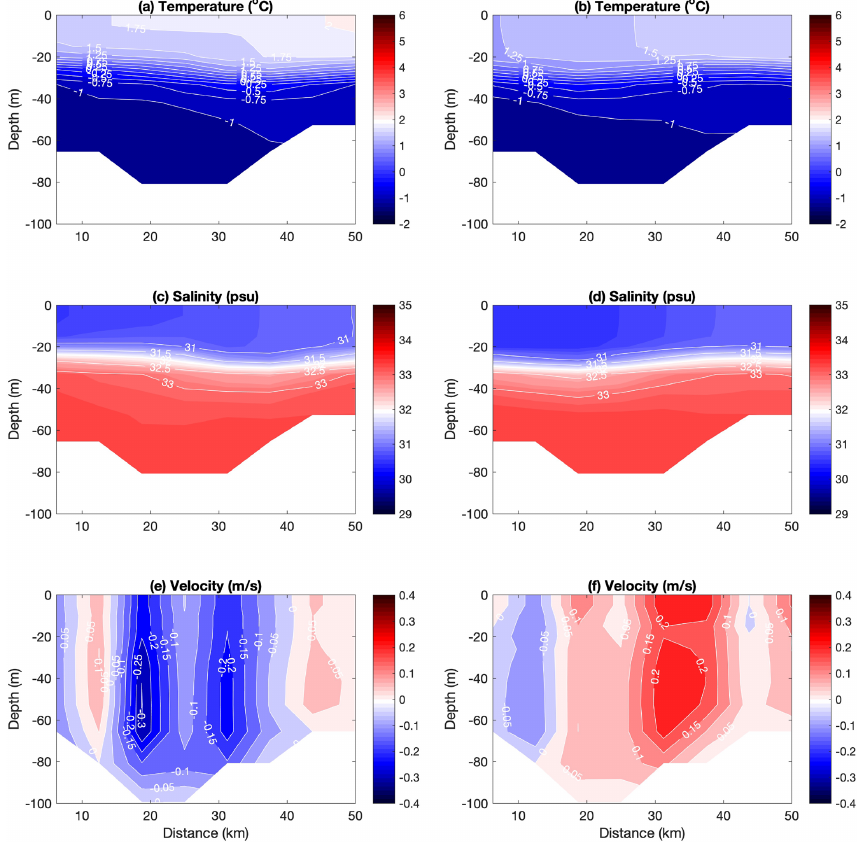
Figure 10. Modelled vertical sections from the 9km simulation across section 3 on 7 September 2008 (a, c, e) and 14 September 2008 (b, d, f) .